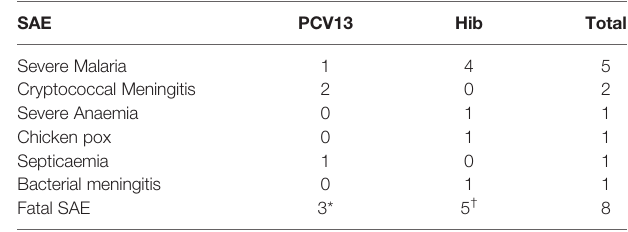
TABLE 6 | Serious adverse events per study